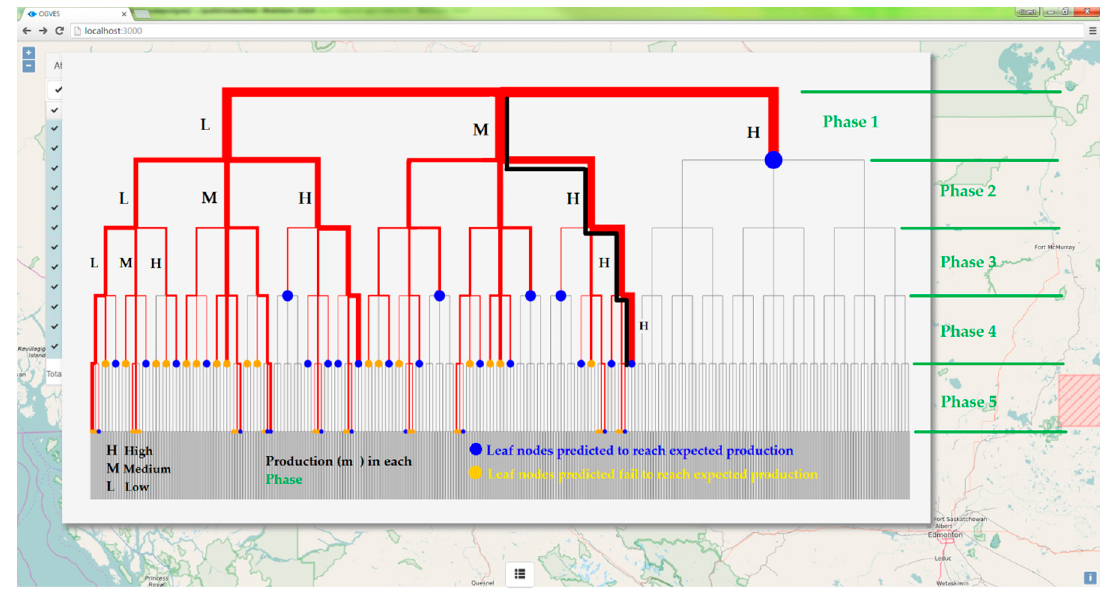
Figure 12. Symbolic tree for shale gas production using symbol size of 3.